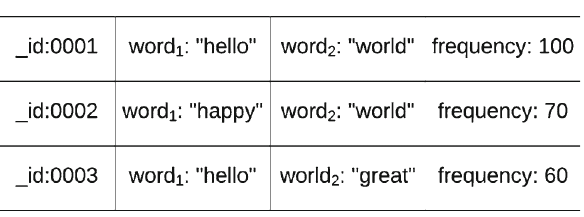
Fig. 4 MongoDB result structure